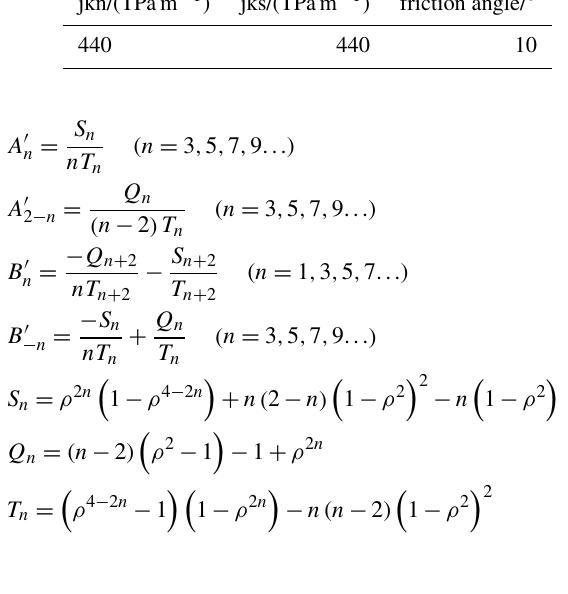
Table 6. Constitutive parameters for interface between canister and